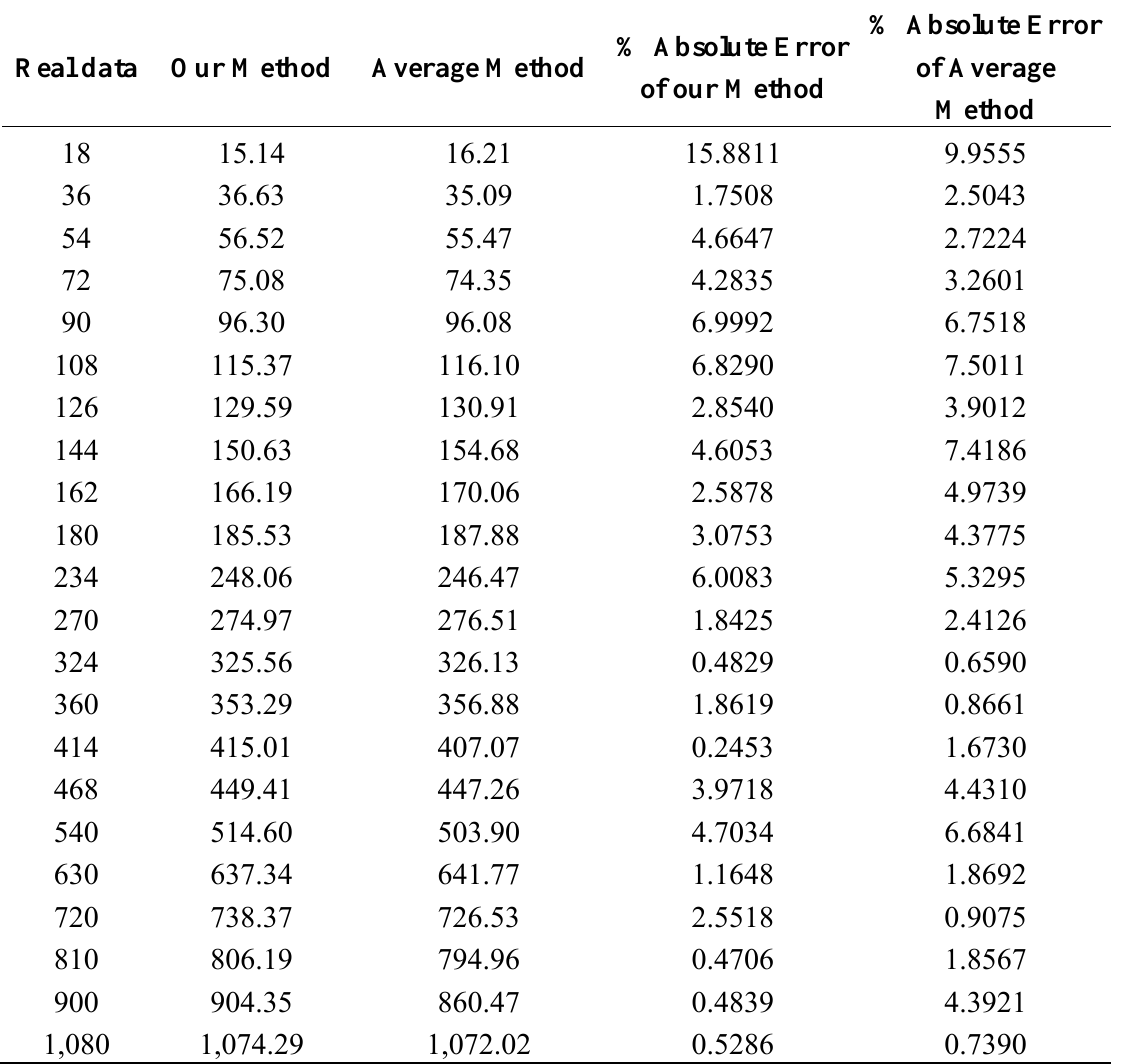
Table 7. Experimental results of benzene.